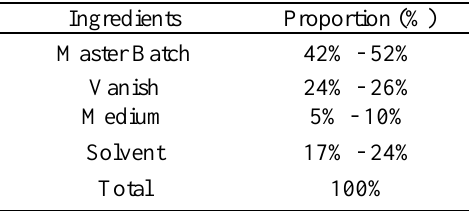
Table 2. Basic composition of NC ink